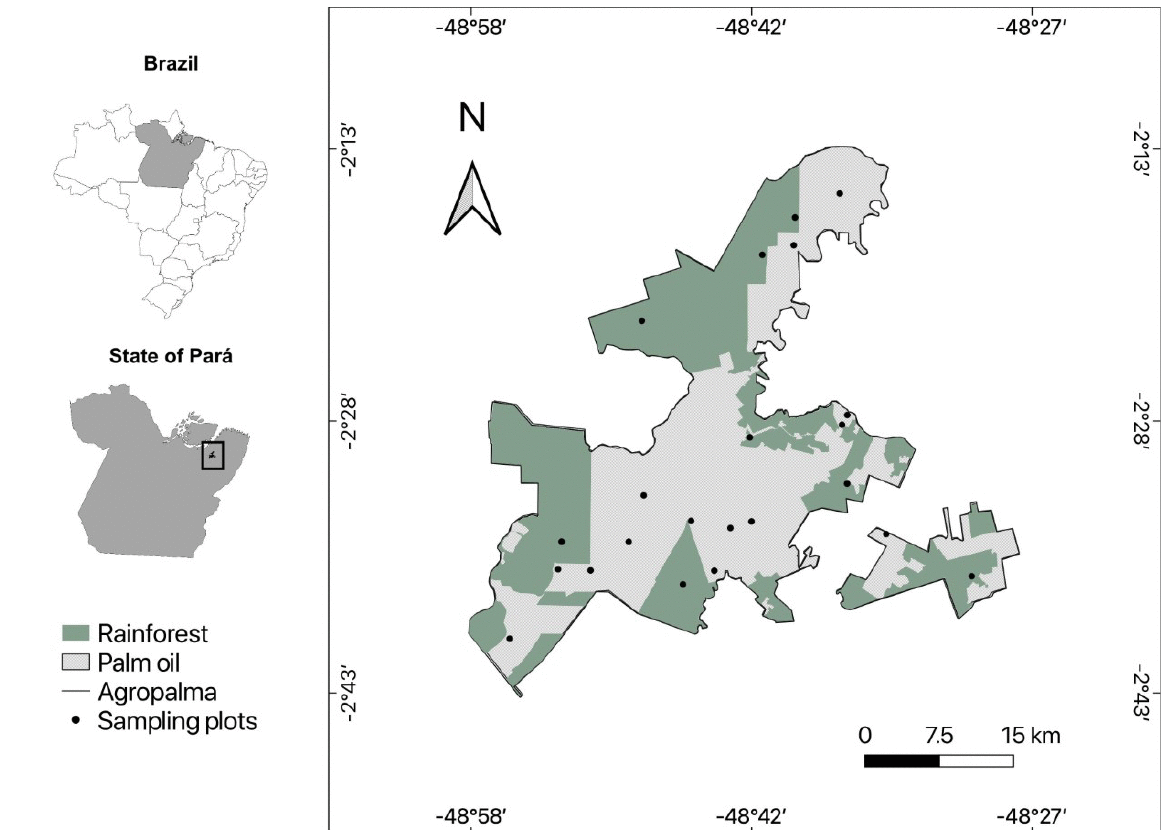
Figure 1. Map of the sampling sites within the property of AGROPALMA Company, in eastern Amazon. Black dots represent sites of forest and oil palm plantations where data was